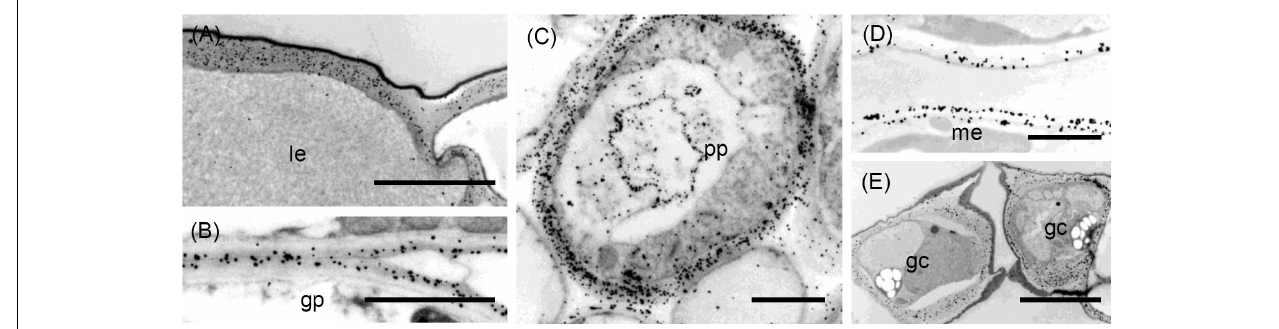
FIGURE 7 | Transmission electron micrographs of transverse sections cut from a rosette leaf of an 8-week-old chicory plant and immunogold labelled with LM6. (A) An epidermal cell in the lamina, showing dense labelling of the outer walls, but light labelling at the junction of two cells. (B) Ground parenchyma cells, showing labelling present in the outer region of the primary walls but no labelling of the corners of intercellular spaces. (C) A phloem parenchyma cell, showing heavy labelling of the walls (D) Mesophyll cells in the lamina, showing labelling in the walls; this labelling appears as two lines in some walls. (E) Stomatal guard cells, showing heavy labelling of the walls. gp: ground parenchyma; gc: stomatal guard cell; le: lamina epidermis; me: mesophyll; and pp: phloem parenchyma. Bars: (A,E) : 5 µ m; (B–D) : 2 µ